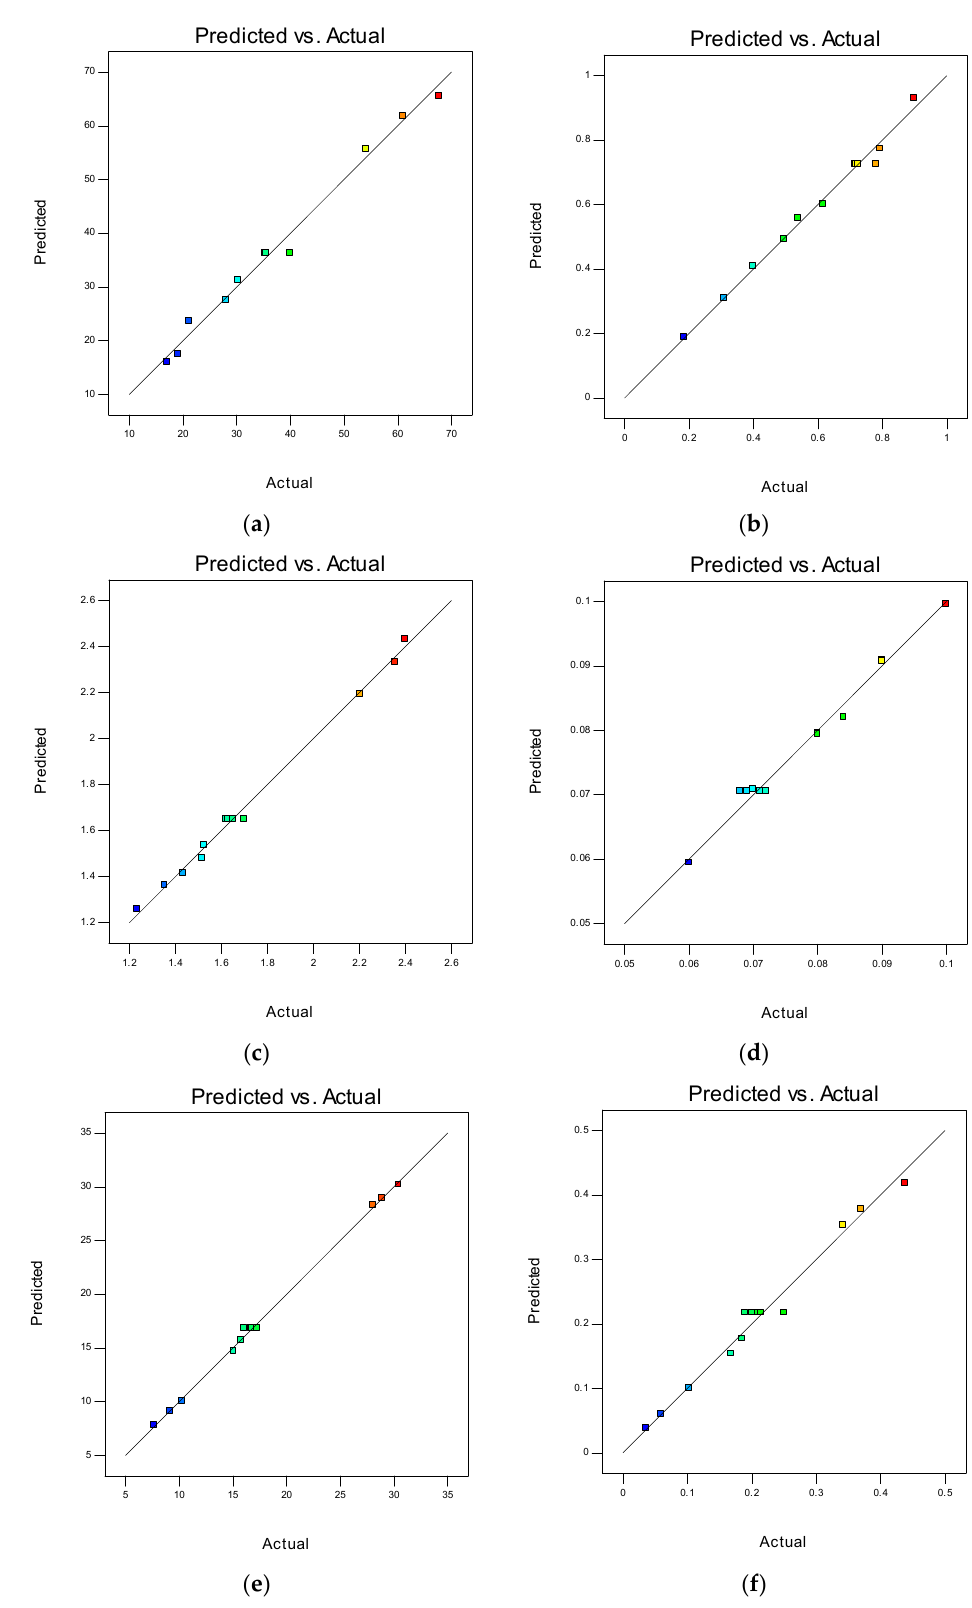
Figure 12. Predicted vs. actual plots for developed response models: ( a ) Compressive Strength; ( b ) Flexural Tensile Strength; ( c ) Direct Tensile Strength; ( d ) Drying Shrinkage; ( e ) Modulus of Elasticity; ( f ) Poisson’s Ratio.